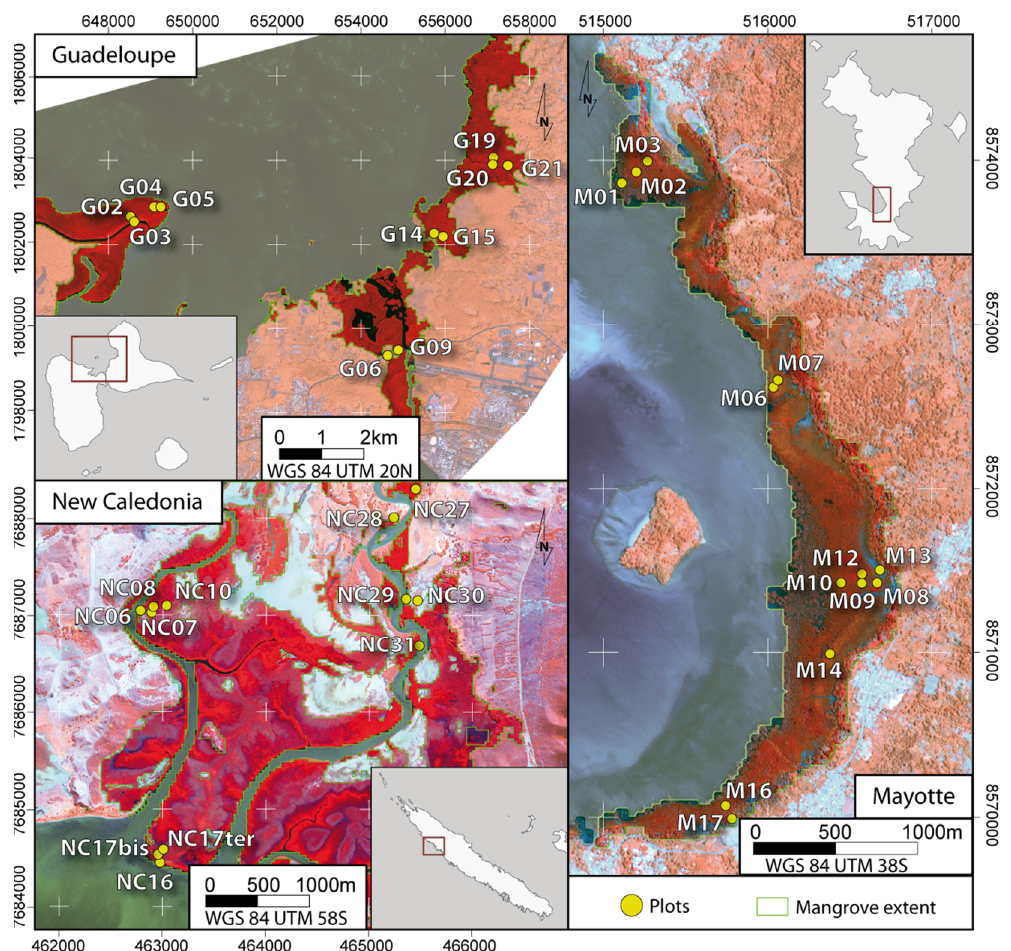
Figure 1. Study sites and location of plots in the three islands (French Overseas Territories) based on Pleiades 1B images.